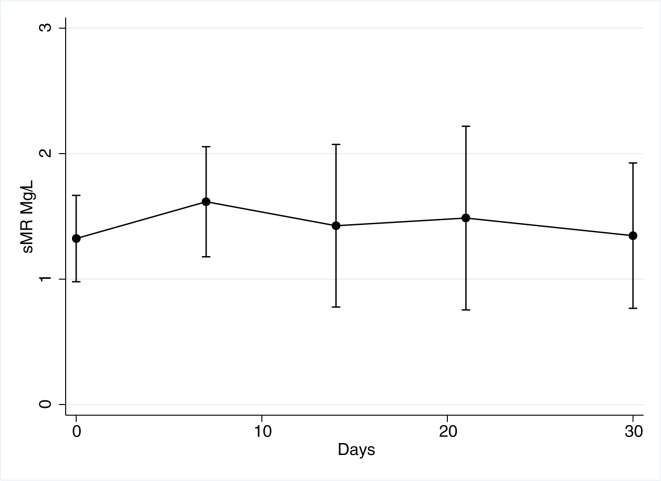
sMR in AH patients over time.sMR levels in Alcoholic hepatitis patients during the 30-day follow-up. (p = 0.07, repeated measures ANOVA).